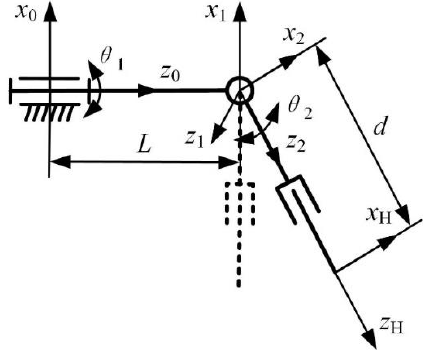
Figure 5. D-H coordinate system of surgical robotic arm.